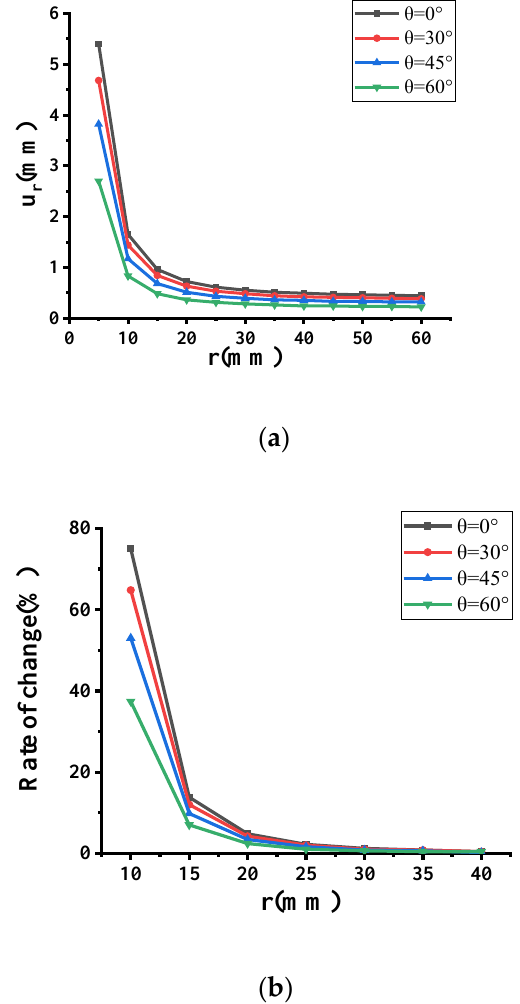
Figure 5. Variation of u r in radial displacement. ( a ) Radial displacements at different distances. ( b ) Radial displacement decreases with radius.